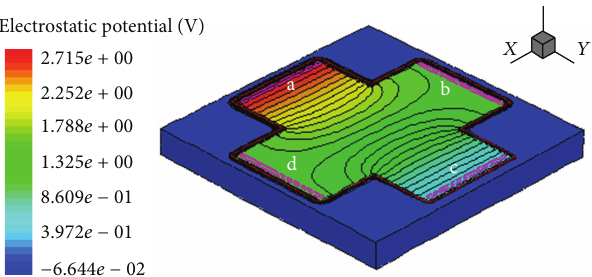
Figure 6: Three-dimensional representation of XL Hall cell with the electrostatic potential distribution.